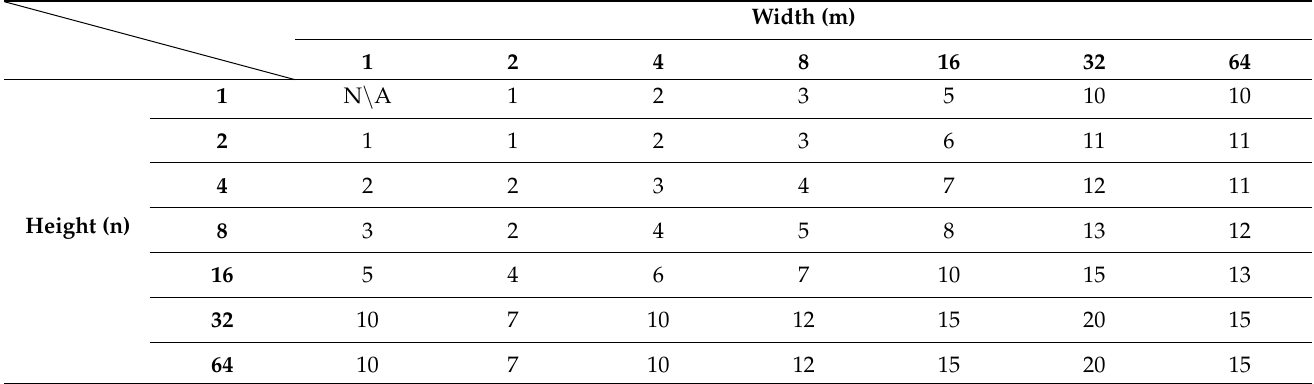
Table 6. Threshold representing the number of non-zero coefficients in each block size, when the horizontal and vertical kernels are DCT-II/DCT-II or other combinations listed in Table